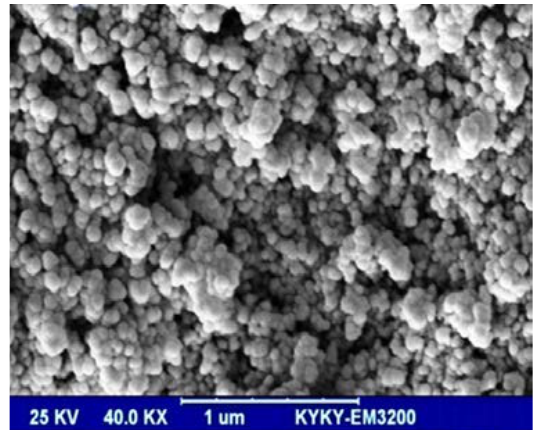
Fig. 1. Scanning electron microscope (SEM) image of NSPs.